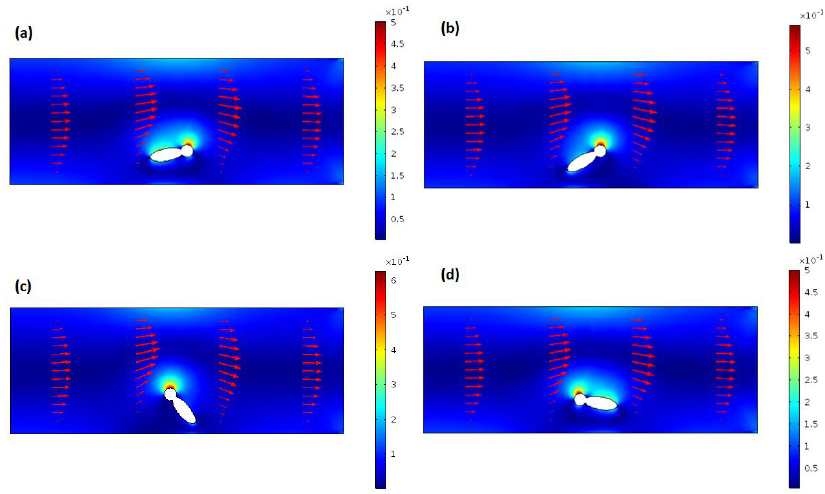
Figure 4. The image shows four of the different angular orientation for the ellipse used for the numerical simulation analysis: ( a ) 10°; ( b ) 30°; ( c ) 120° and ( d ) 170°. The color-map refers to the vorticity field magnitude (lowest magnitude in dark blue, higher magnitude in red).